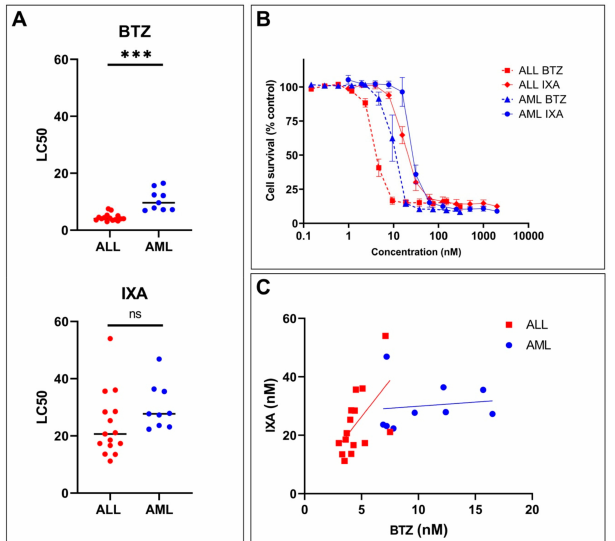
Figure 4. Sensitivity of primary pediatric (relapsed) ALL and AML patient samples to IXA and BTZ. ( A ) Individual LC 50 values (nM) for IXA and BTZ as obtained after 4-day drug exposure and MTT cytotoxicity assay analysis in ALL and AML patient samples. The line indicates the mean LC 50 value (nM), *** indicates p < 0.0001. ( B ) Combined dose–response curves of cell survival (relative to control set at 100%) of ALL and AML cells exposed for 4 days to IXA and BTZ. Results present the mean cell survival at each drug concentration ± SEM. ( C ) Correlation of the LC 50 values (nM), from Figure 4A, for IXA and BTZ in ALL and AML patient